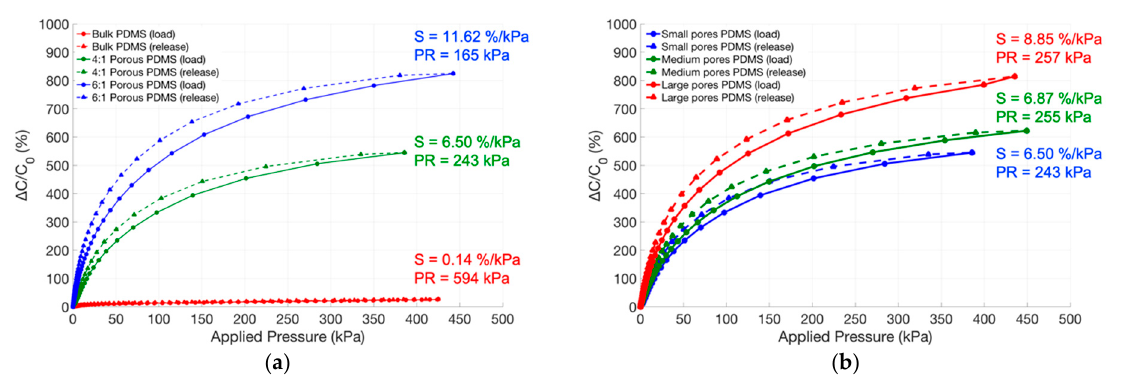
Figure 4. Variation of the sensor capacitance according to the applied pressure ( a ) Depending on the sugar:PDMS ratio; ( b ) Depending on the micropore